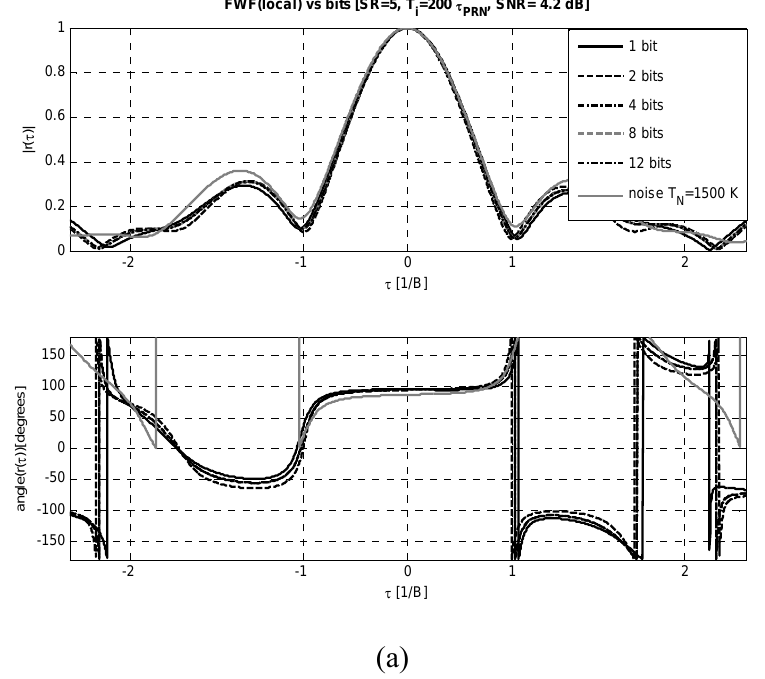
= 1500 K (Figure N = 1500 K N